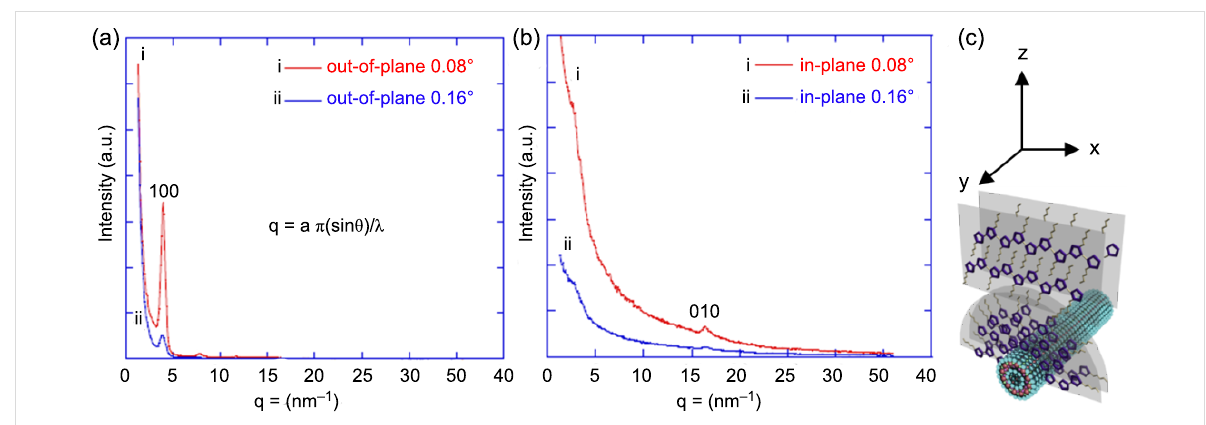
Figure 24: Out-of-plane (a) and in-plane (b) GIWAXD patterns of P3HT/HT3P-imogolite nanofiber hybrid. (c) Schematic illustration of the molecular arrangement of P3HT on imogolite. Reprinted with permission from W. O. Yah et al., J. Phys.: Conf. Ser. 2011, 272, 012021 [86]. © IOP Publishing